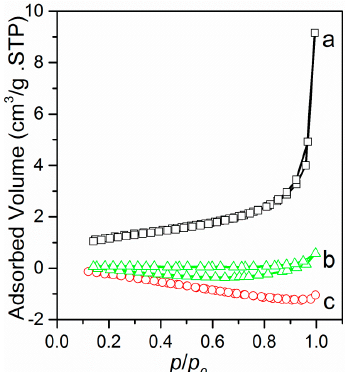
Figure 3. N 2 sorption isotherms of the lysine-loaded microparticles obtained with an ethanol/water solvent of 4:1 volume ratio at a drying temperature of 100 ( a ); 155 ( b ); and 205 °C ( c ), respectively.